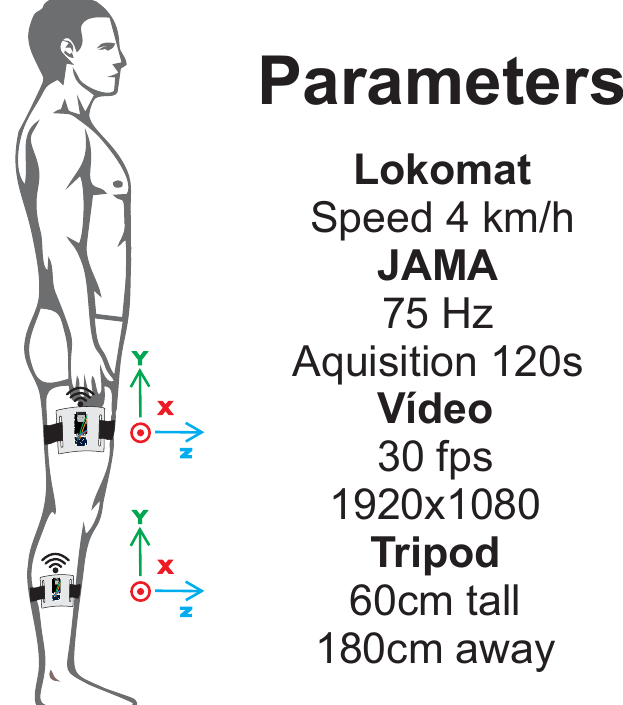
Figure 4. Experiment 2. Figure shows the positioning of the two JAMAs used to assess the knee joint with the parameters for data acquisition. One JAMA was positioned above and the other below the joint, using 75 Hz of acquisition frequency. Camera was positioned 180 cm away and 60 cm high on a tripod. Video was recorded in full HD resolution at 30